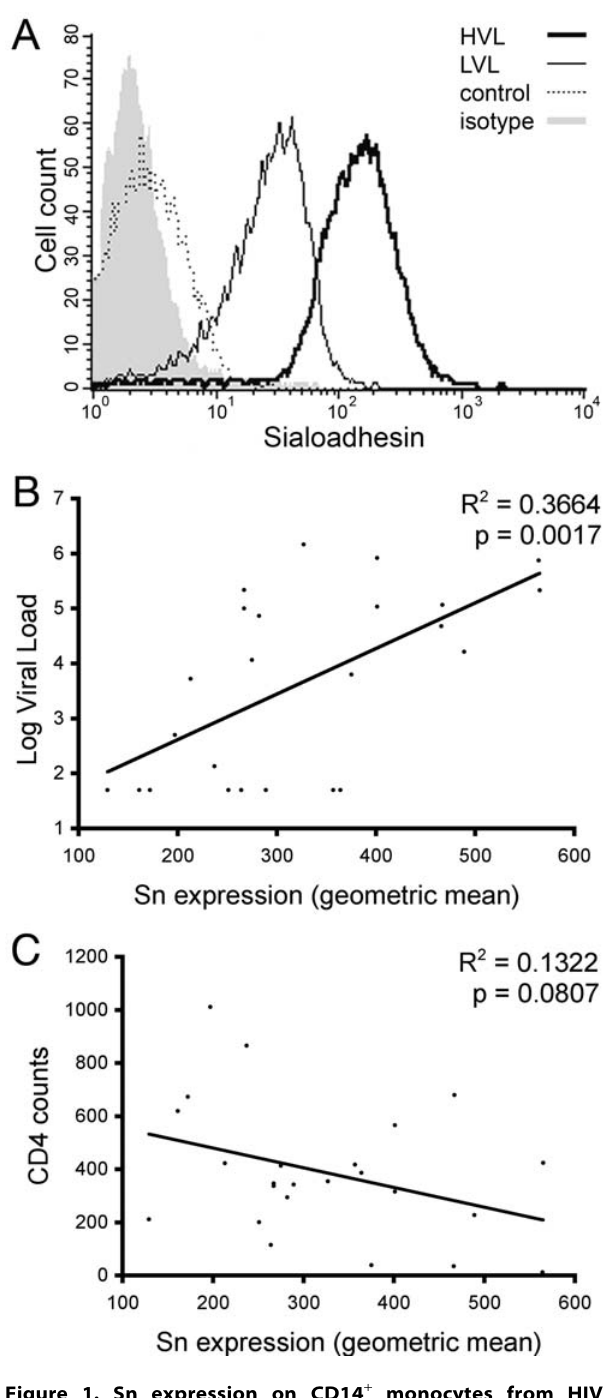
Figure 1. Sn expression on CD14 + monocytes from HIV seropositive individuals. (A) Representative frequency histograms of relative Sn expression on CD14 + monocytes isolated from subjects with high viral load (HVL, 214,000 RNA copies/ml, thick black line), low viral load (LVL, 6,350 RNA copies/ml, thin black line) and a seronegative control (dotted line). The isotype-matched control mAb is shown in the shaded profile. (B) Correlation analysis of Sn expression and viral load. Sn expression on CD14 + monocytes from HIV seropositive subjects (Table 1, n=24) was determined by flow cytometry and quantified as a geometric mean for each subject. Pearson’s correlation analysis showed statistical significance between Sn expression and the log of the subject’s viral load (p , 0.0017). (C) Correlation analysis of Sn expression and CD4 (counts/ml) revealed no significant relationship (p , 0.08).